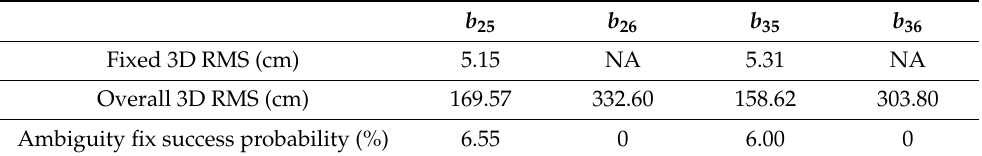
Table 6. DD integer ambiguity fix success probabilities and 3D RMS position errors of the baselines across the two cells using a one-to-one RTK with six common satellites in view in Figure